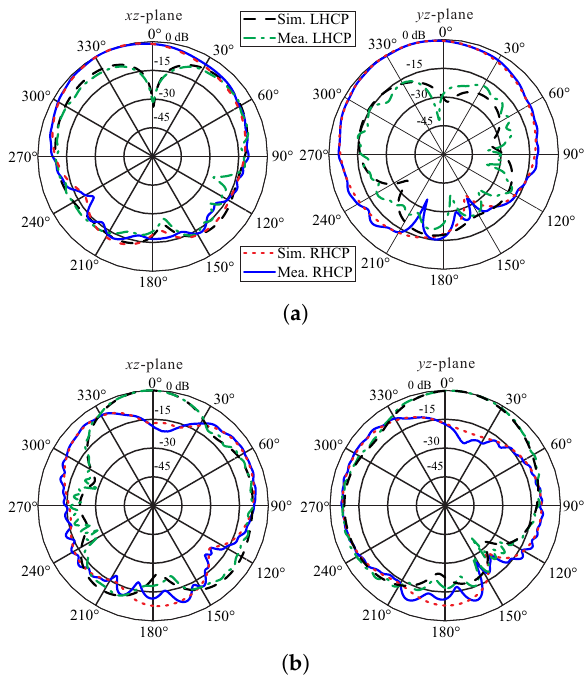
Figure 10. Normalized simulated and measured radiation patterns of the proposed DRA: ( a ) 2.46 GHz; ( b ) 3.5 GHz.